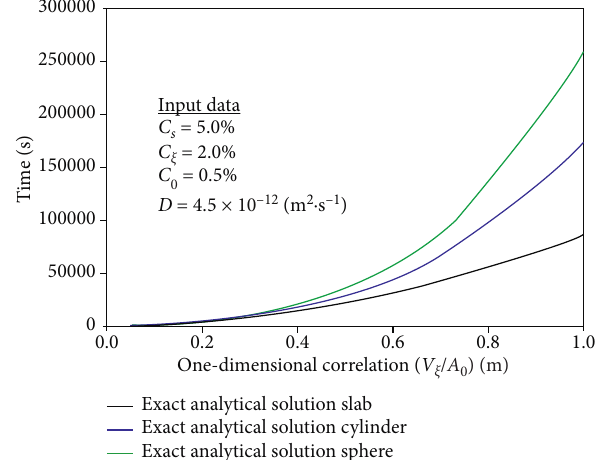
Figure 15: Comparison of similarity variables in relation to the moving interface dimensionless position R diffusion of a slab, a cylinder, and a sphere at 70% of R